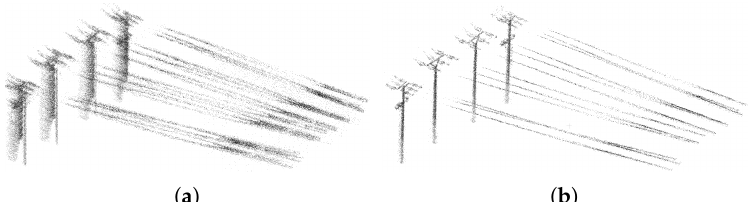
Figure 25. Example of ambiguities caused by reconstruction errors ( a ), which disqualifies the model to be used for practical measurements. We obtained such results when we used only poses provided by GNSS/INS subsystem without any refinements by SLAM or point cloud registration. Our solution (including SLAM) provides valid reconstructions ( b ), where both towers and wires (in this case) can be